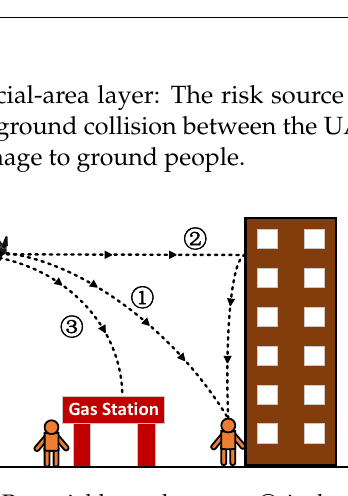
Figure 2. Potential hazard events. ① is the ballistic descent; ② is the obstacle collision; ③ is the secondary damage.